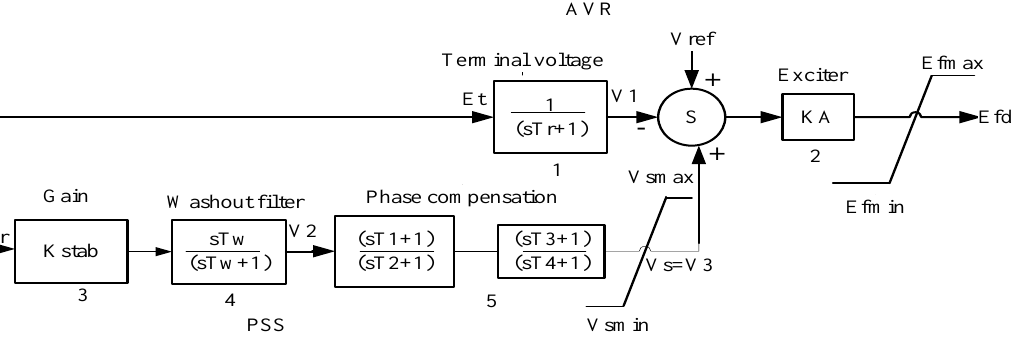
Figure 2. Thyristor excitation system with AVR and PSS.